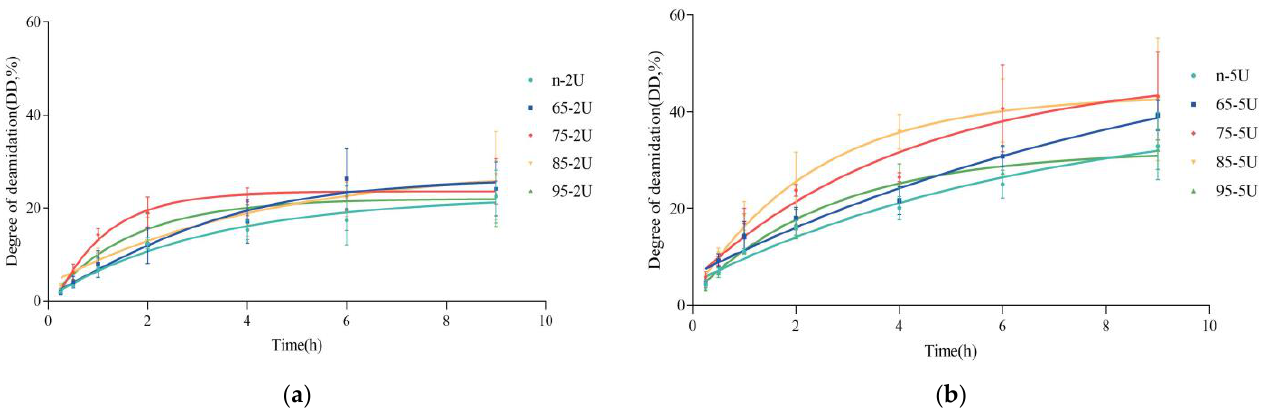
Figure 1. The degree of deamidation (DD, %) of SPI induced by protein-glutaminase (PG) deami- dation with time reaction. ( a ): addition of 2 U/g PG; ( b ): addition of 5 U/g